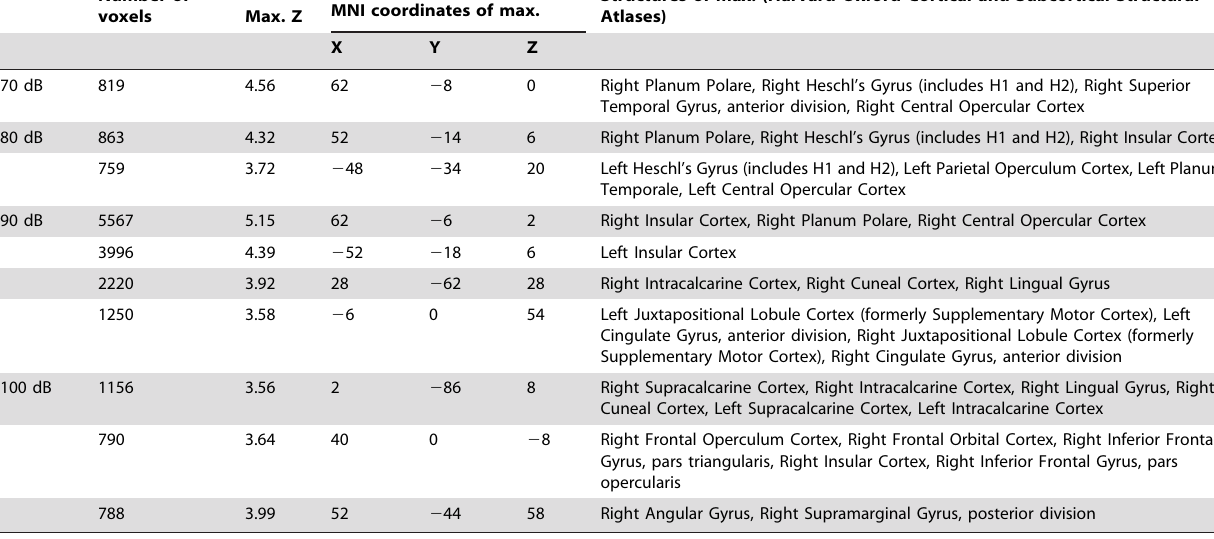
Number of voxels Max. Z MNI coordinates of